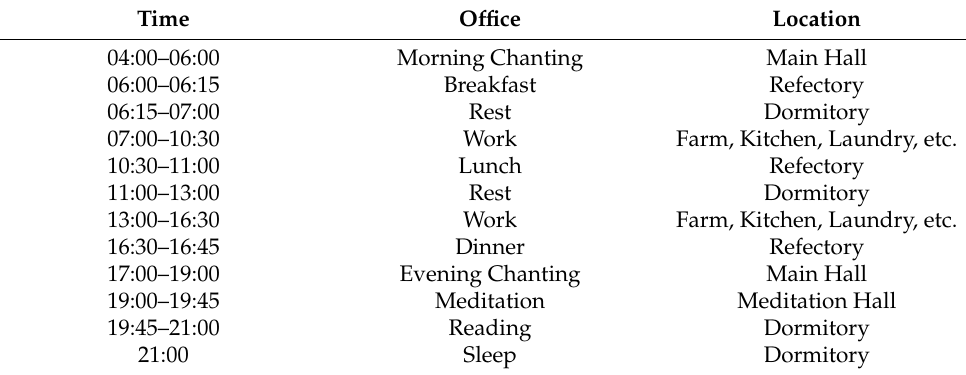
Table 1. Daily Routine for Buddhist Monastic Life (Guoqing Si).